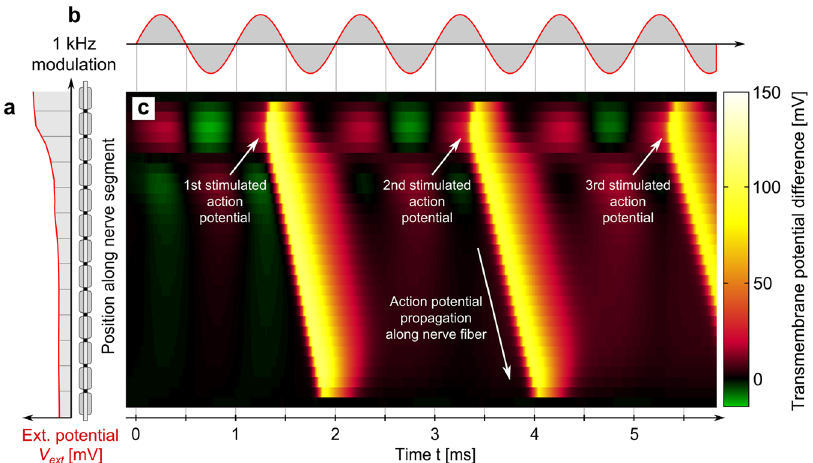
Figure 6. Exemplary evaluation of the nerve membrane model. ( a) Potential created by coil along the nerve segment (V ext ). ( b) Time modulation of V ext (1 kHz sinusoid at 125% of the PNS threshold). ( c) The transmembrane potential as a function of space (position along the nerve, vertical axis) and time (horizontal axis) showing the creation of an action potential which then travels with a fixed velocity in space.